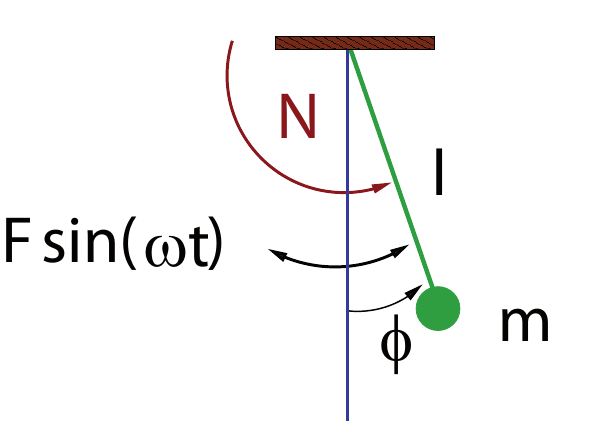
Figure 1. A schematic of a periodically driven